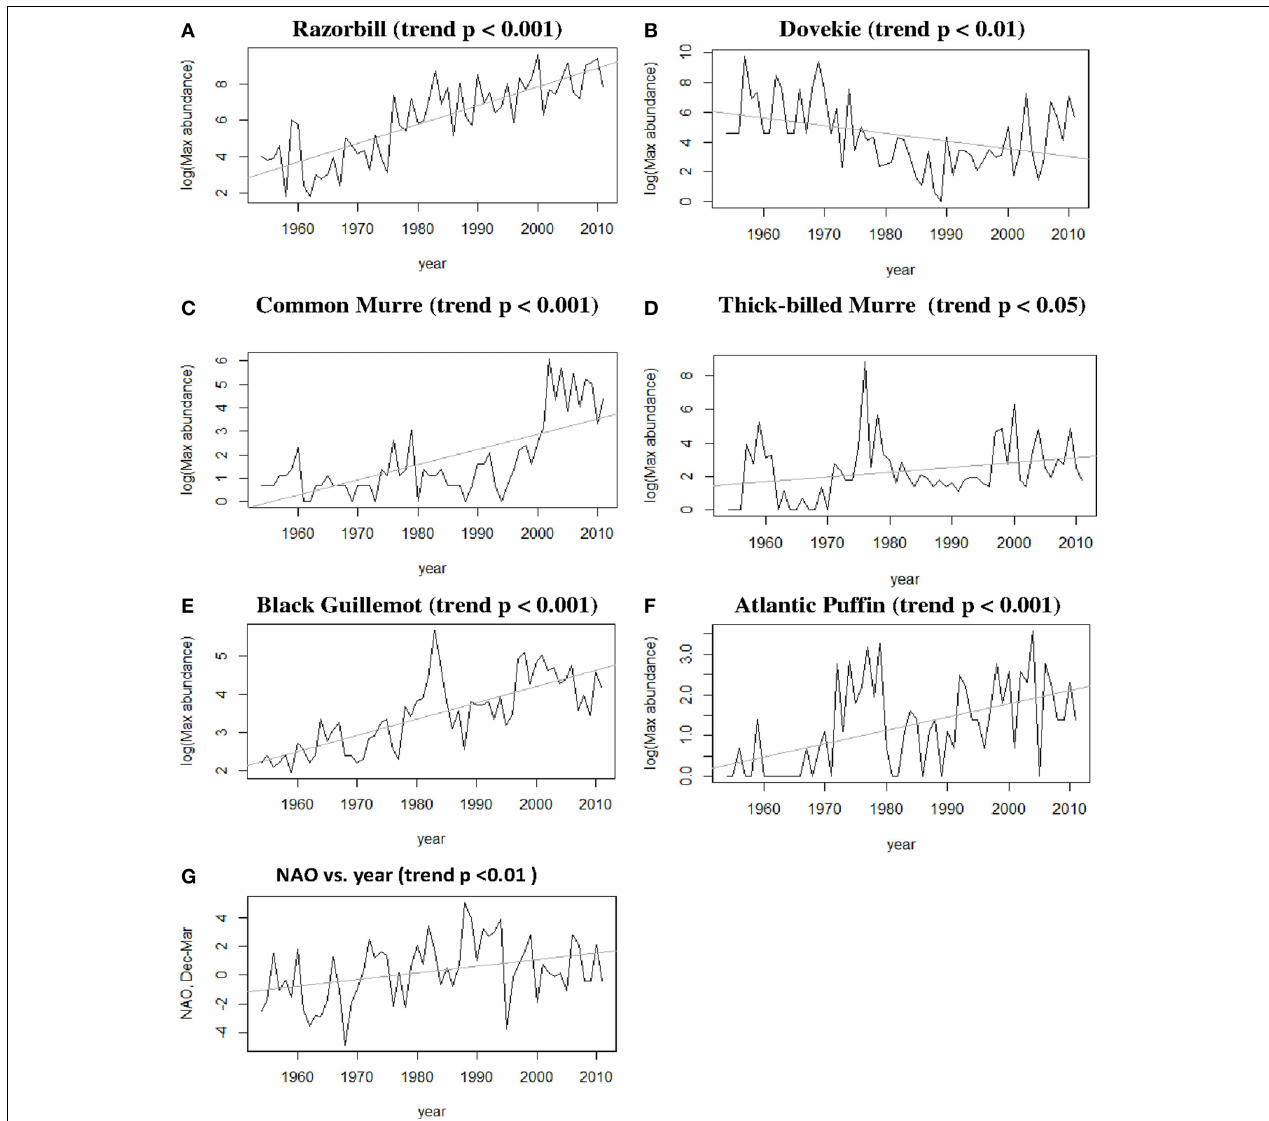
FIGURE 3 | (A–F) Winter abundance (raw time series) of alcids in Massachusetts over the period 1955–2012; (G) NAO over time, showing both trend and periodic